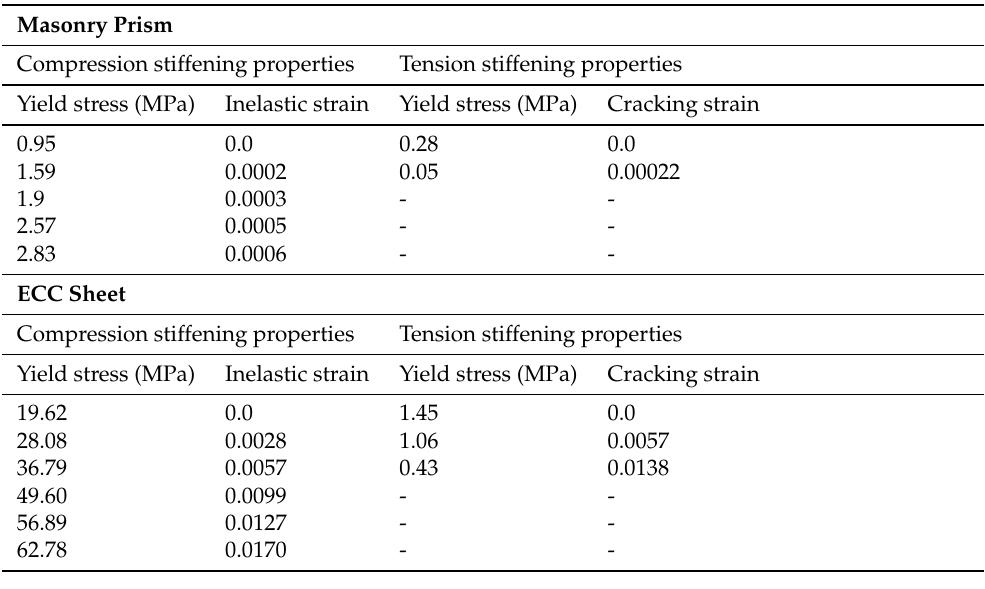
Table 5. Yield stress and corresponding strain values of masonry prism and ECC sheet